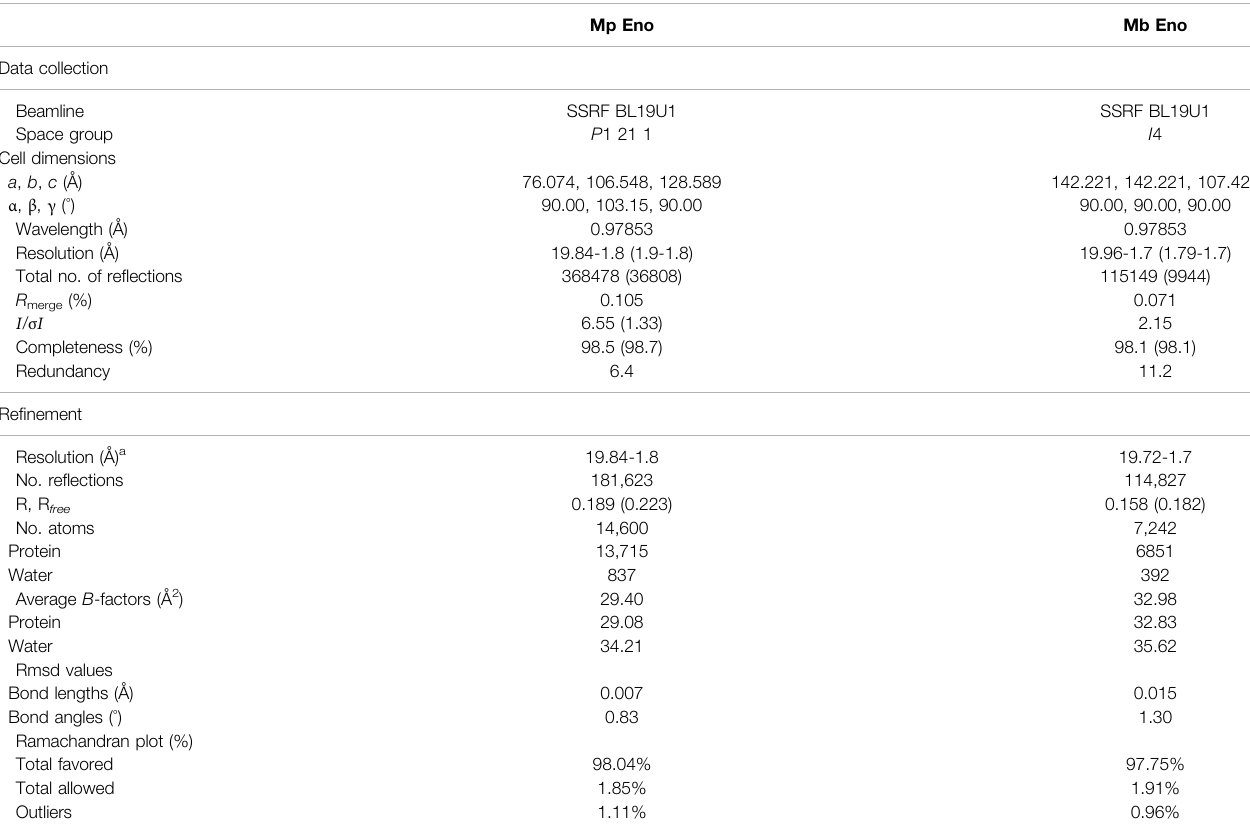
TABLE 2 | Data collection and re fi nement